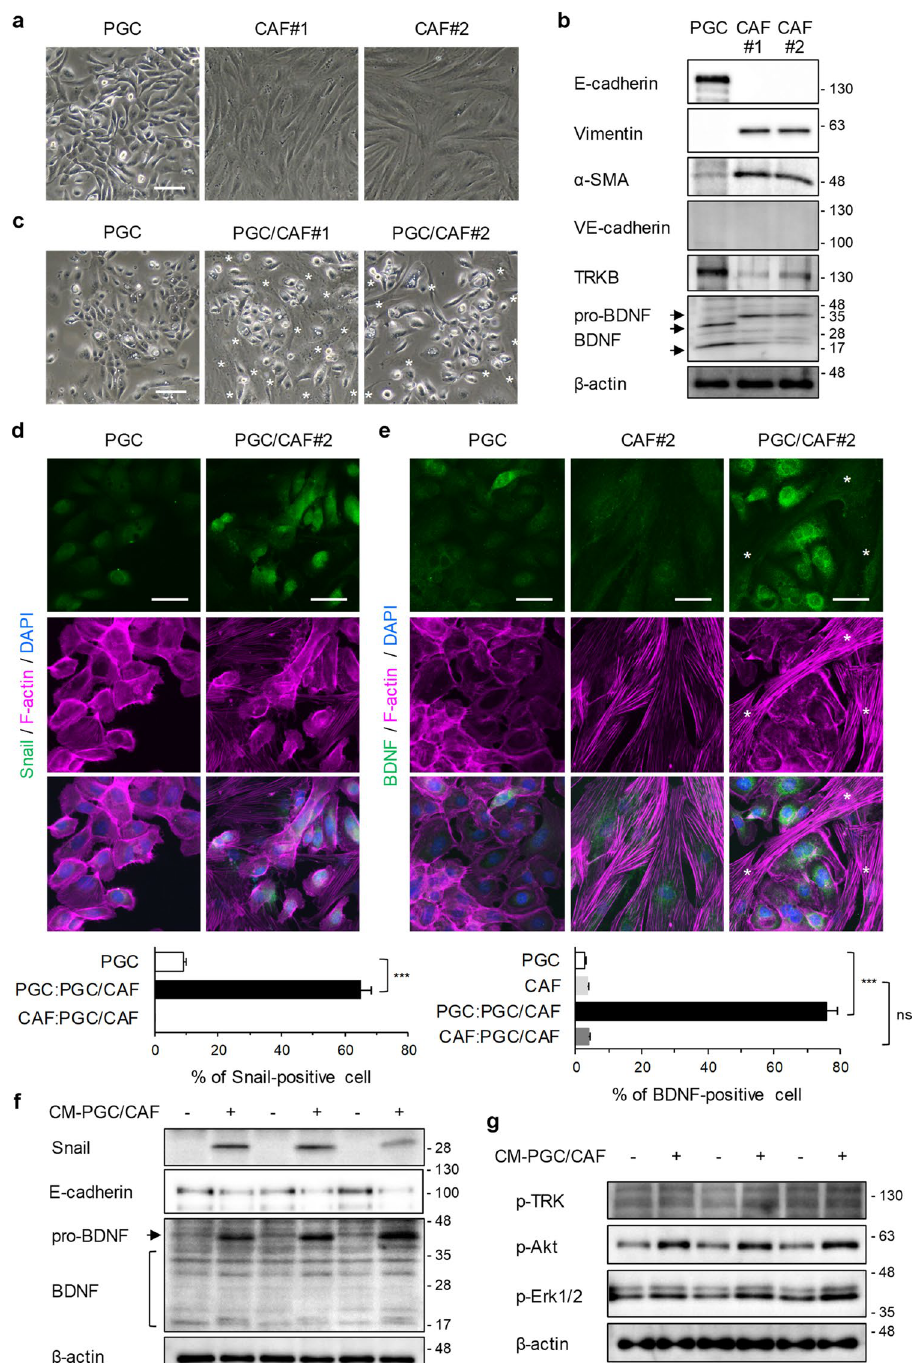
Figure 2. Promotion of EMT and upregulation of BDNF in PGC cells by co-culture with CAFs. (a) Representative phase- contrast images of isolated PGCs and CAFs. Scale bar, 200 μm. ( b) Characterization of established PGC cells and CAFs by WB analysis using the indicated antibodies. ( c–e) Representative images of phase contrast ( c ) and immunofluorescence staining for Snail ( d ) and BDNF ( e ) in PGC cells which were mono-cultured or co-cultured with CAFs for 4 days. Scale bars, 200 μm ( c ) and 50 μm ( d,e ). Asterisks indicate CAFs. PGC, single-cultured PGC cells; PGC/CAF, direct-co-cultured PGC cells and CAFs. Histograms depict the percentages of Snail- or BDNF-positive cells per field as the mean ± SEM. The percentages were calculated from more than 12 fields (at least 100 cells per field) of each group. PGC:PGC/CAF, direct-co-cultured PGC cells with CAFs; CAF:PGC/CAF, direct-co-cultured CAFs with PGC cells. *** P < 0.001; ns not significant (Student’s t -test). ( f) Expression of Snail and BDNF in PGC cells was determined by WB analysis. PGC cells were cultured for 4 days with control cell-free conditioned medium (CM) from PGC cell cultures or CM from PGC/CAF co-cultures. ( g) Phosphorylation levels of TRK and its down streams, Akt and Erk1/2 were examined by WB analysis. Briefly, PGC cells were serum-starved for 24 h and treated with CM from PGC/CAF co-cultures for 10